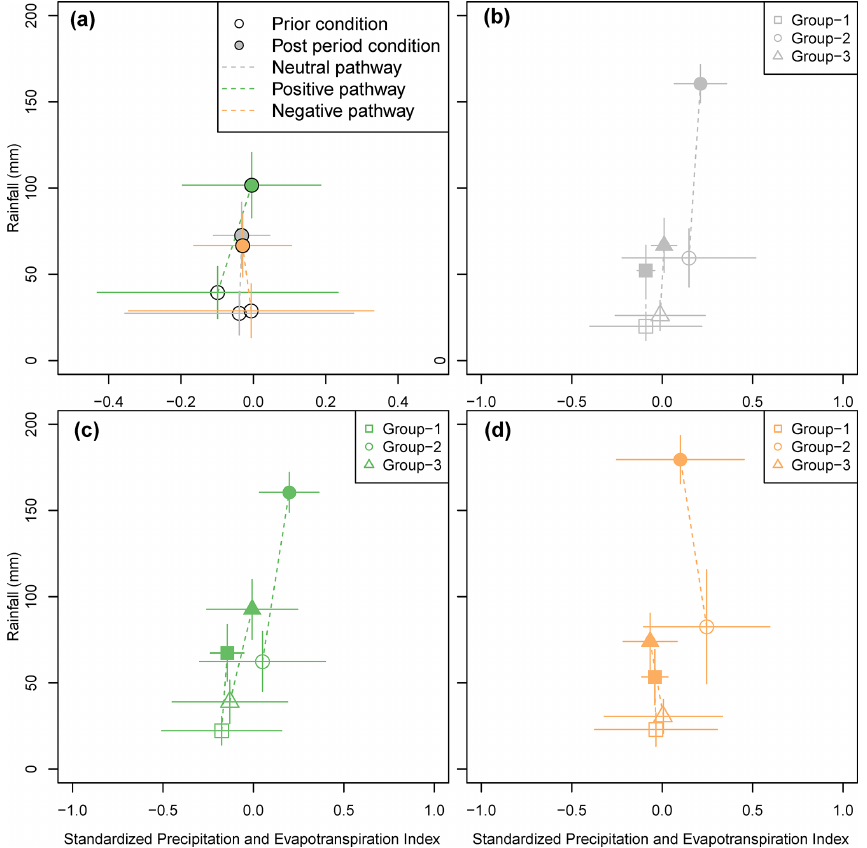
Figure 1. Changes in standardized precipitation and evapotranspiration index following the precipitation brought by tropical cyclones. (a) Response in standardized precipitation and evapotranspiration index following the passage of a tropical cycle that resulted in a decrease (orange), no change (gray), or increase (green) in leaf area. Increasing leaf area was observed in forests that experienced a dry spell prior to the passage of a cyclone that brought sufficient precipitation to end the dry spell. (b–d) Response in standardized precipitation and evapotranspiration index following the passage of a tropical cycle that resulted in no change (gray; b ) an increase (green; c ), and a decrease (orange; d ) in leaf area for the three cyclone groups (Table 1). Similar responses hint at similar mechanisms underlying the responses in leaf area irrespective of the cyclone group. The dashed line indicates the pathway moving from the condition prior to the condition after the passage of the